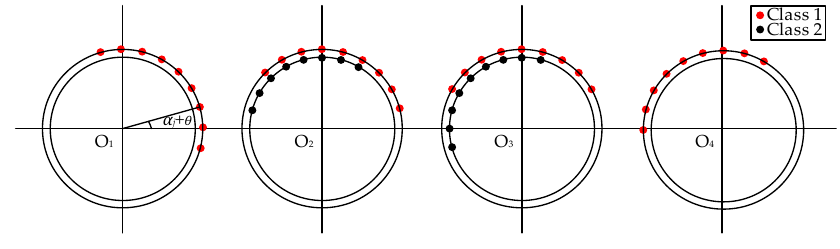
Figure 10. The TD distributions at each measurement point.